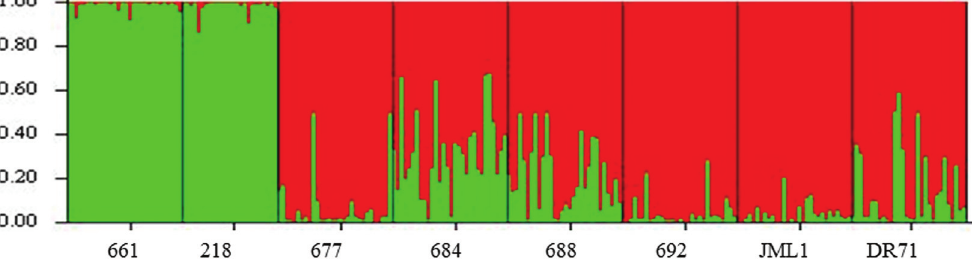
Figure 2 - Bayesian admixture proportions ( Q ) of individuals of Calydorea crocoides para K = 2 identified in the STRUCTURE, shown in different col- ors. The most likely number of populations ( K ) was estimated with the admixture model and correlated allele frequencies, with no prior information re- garding population